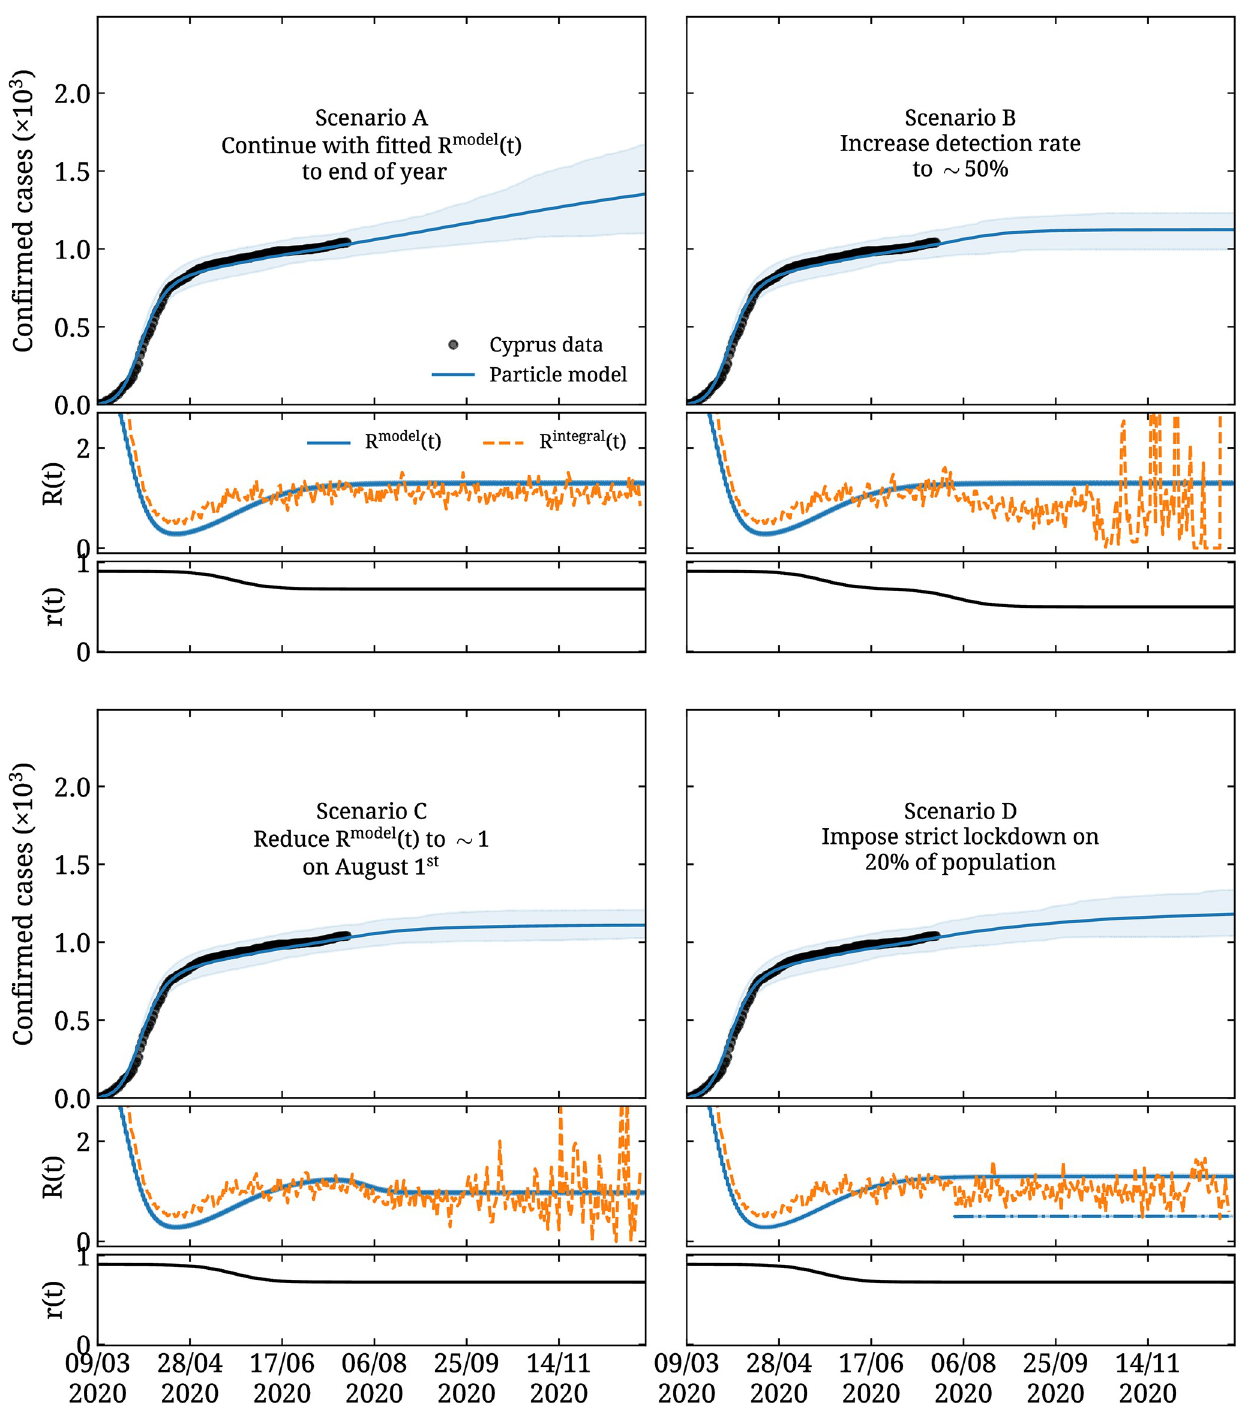
Fig 7. Forecasting using the particle model. Predictions for the same four scenarios as in Fig 6 but using the particle model. In the top part of the plots, the blue curve and associated band is obtained as the average and 90% confidence interval when seeding the model 32 times. In the central part of the plots, we show with the blue curve R model ( t ) and with the orange dashed curve R integral ( t ). The rest of the notation is the same as that used in Fig 6.